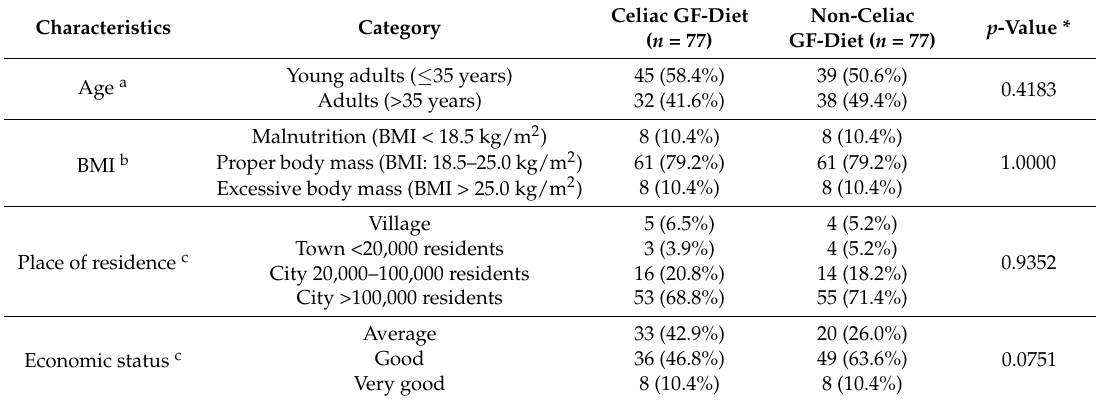
Table 2. The stratification of participants by age, BMI, place of residence, and economic